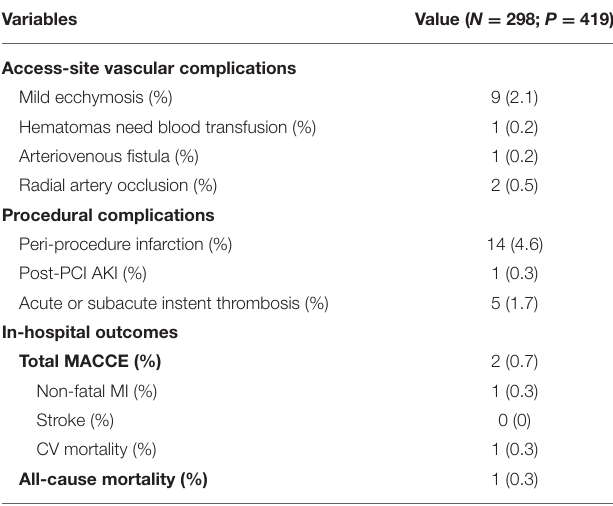
TABLE 4 | Access-site vascular and procedural complications and in-hospital outcomes.